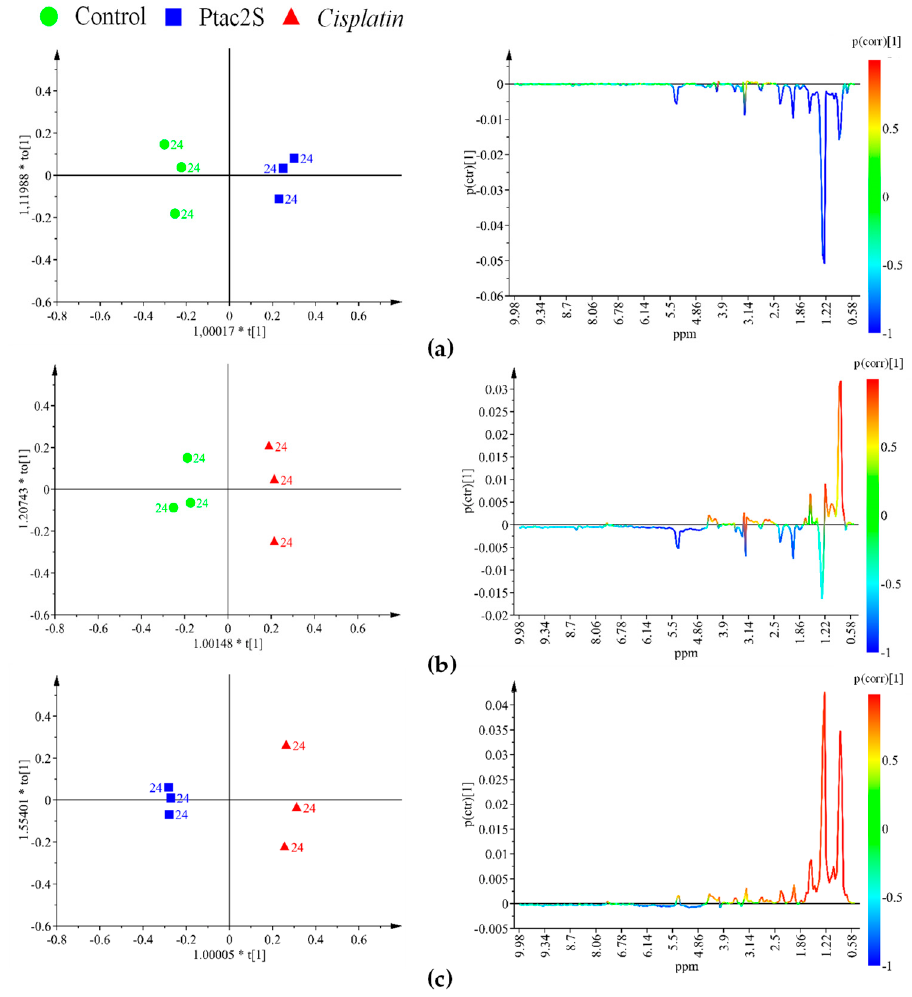
Figure 8. OPLS-DA score plot (left panel) and corresponding coefficient plot (right panel) of the 600 MHz 1 H-ZG-NMR spectra (Pareto scaled) of SKOV-3 cells lipophilic extracts obtained from different pairwise groups (controls, Ptac2S, and cisplatin) at 24 h. ( a ) OPLS-DA t[1]/t[2] scores scatter plot (two components, 1 predictive + 1 orthogonal give R 2 X = 0.887, R 2 Y = 0.986, Q 2 = 0.944. ( b ) OPLS-DA t[1]/t[2] scores scatter plot (two components, 1 predictive +1 orthogonal give R 2 X = 0.784, R 2 Y = 0.985, Q 2 = 0.936). ( c ) OPLS-DA t[1]/t[2] scores scatter plot (two components, 1 predictive + 1 orthogonal give R 2 X = 0.893, R 2 Y = 0.996, Q 2 = 0.932).